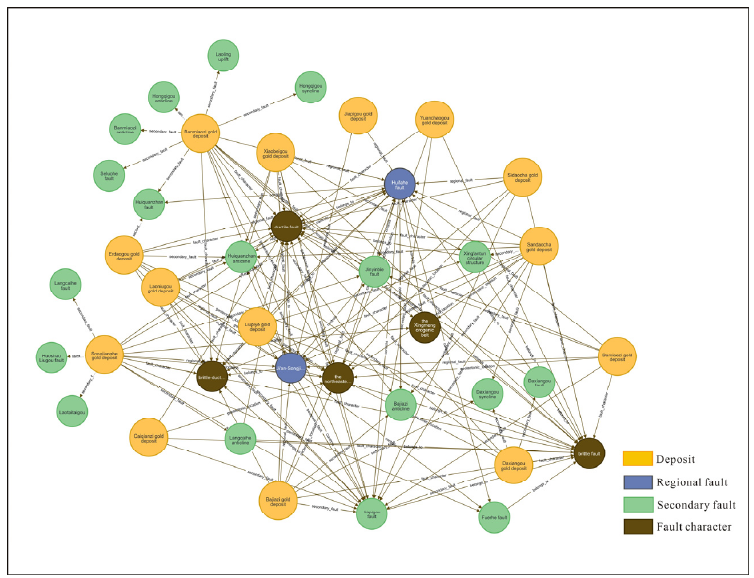
Figure 11. A subgraph for the regional fault, secondary fault, fault character, and ore deposits.